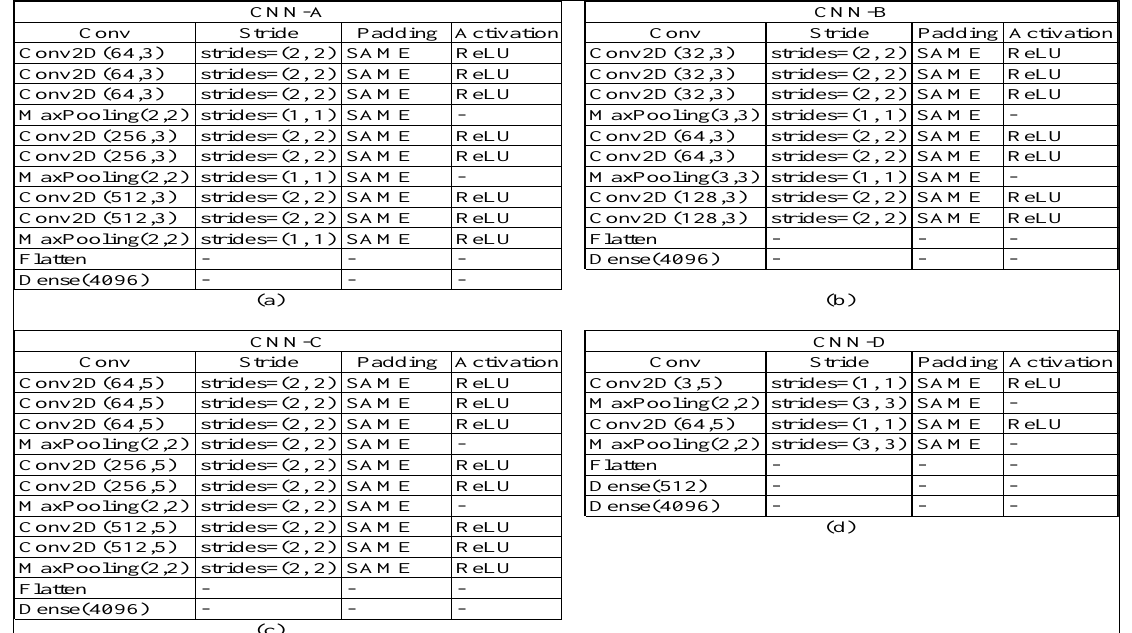
Figure 5. Architectures of proposed CNN models. ( a ) CNN with seven layers convolutional and uses three layers of MaxPooling, ( b ) CNN with seven layers convolutional and two layers of MaxPooling, ( c ) same as ( a ) but different size of MaxPooling, ( d ) CNN with two layers convolutional, two MaxPooling layers, and two fully connected (FC) layers.